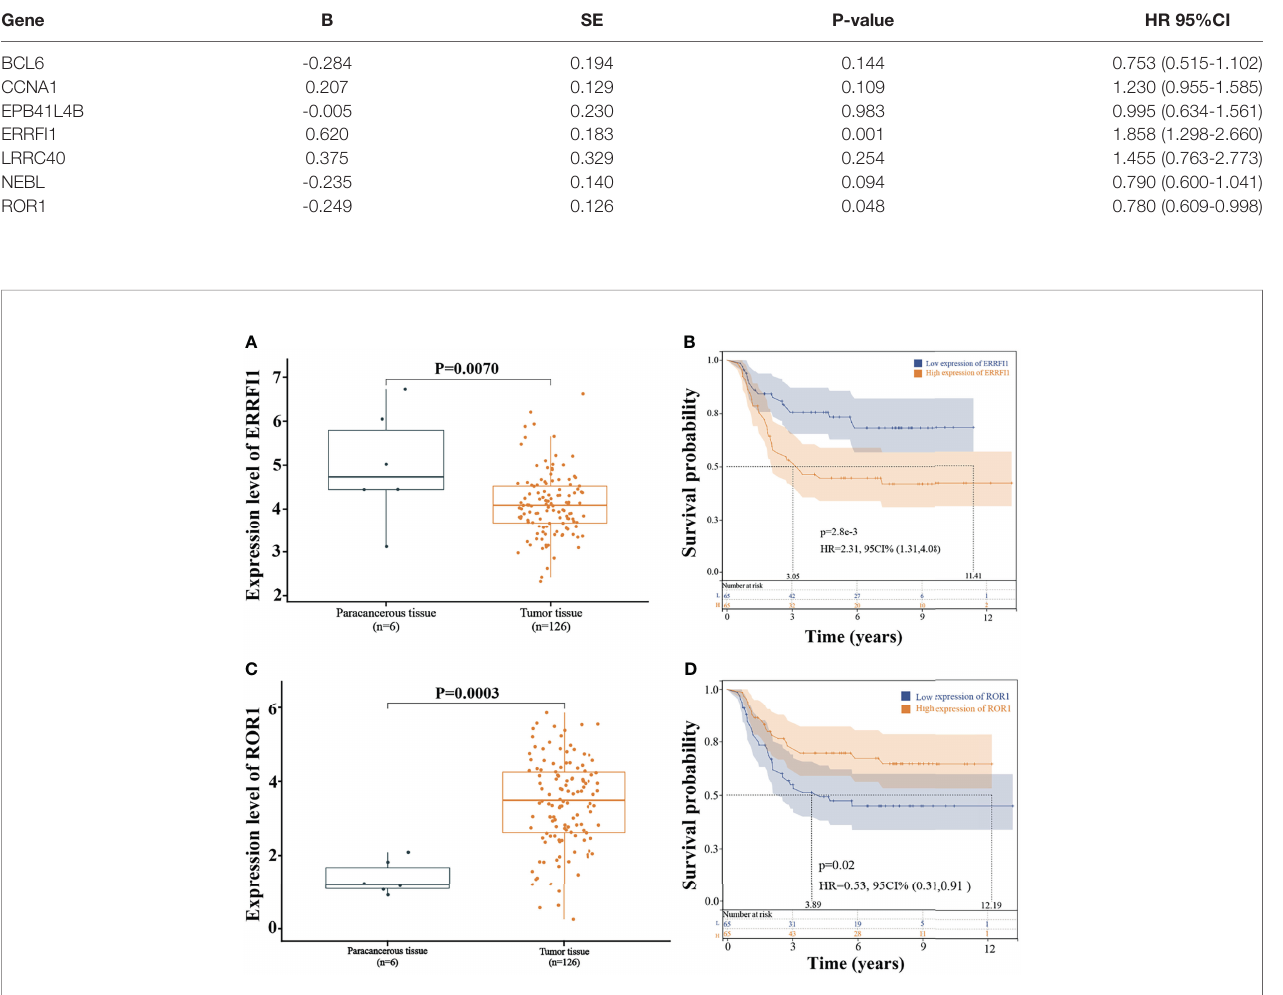
FIGURE 6 | Expression and prognosis of ERRFI1 and ROR1. (A) Expression level of ERRFI1 in the TARGET-WT database; (B) Prognosis analysis of ERRFI1 in the TARGET-WT database; (C) Expression level of ROR1 in the TARGET-WT database; (D) Prognosis analysis of ROR1 in the TARGET-WT database.